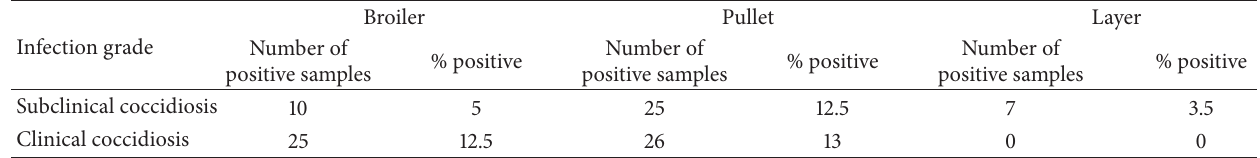
Table 3: Prevalence rate of different Eimeria species in free-range chicken in Sidi Thabet, Tunisia. Bird type Broilers Pullet Layer Prevalence Eimeria spp.